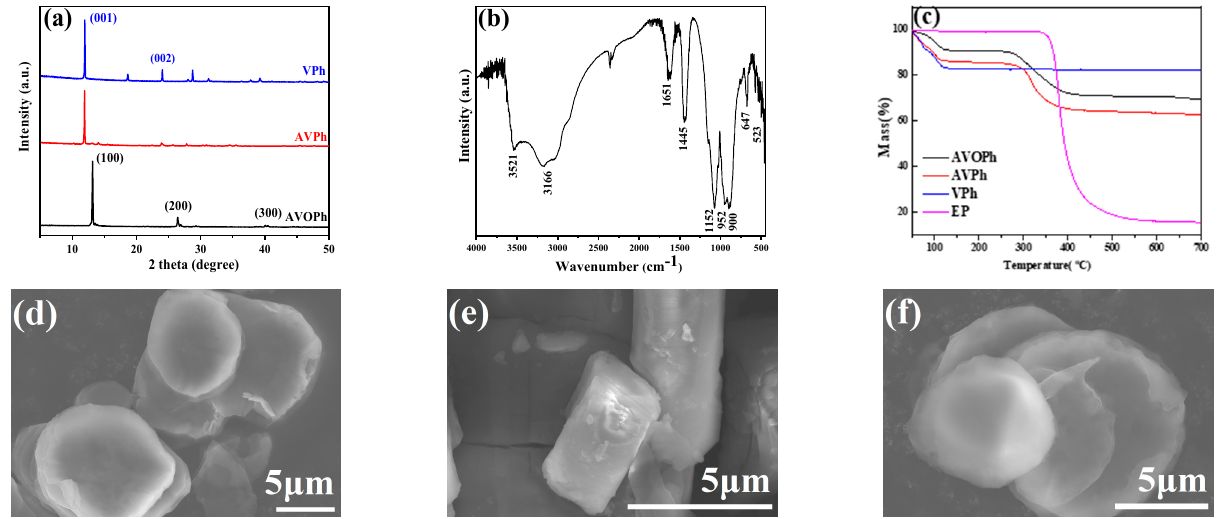
Figure 1. ( a ) XRD pattern of AVOPh, AVPh, and VPh; ( b ) FTIR spectrum of AVOPh; ( c ) TGA curves of AVOPh, AVPh, VPh, and EP; ( d – f ) SEM images of AVOPh, AVPh, and VPh.